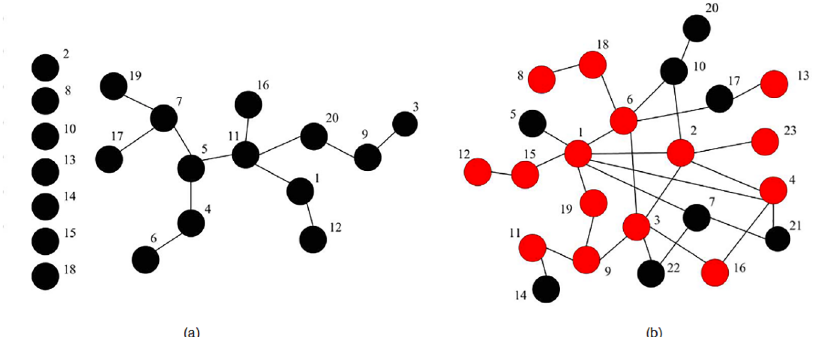
Fig 6. Interaction relations among high-connectivity players and their strategies in the stationary regime of evolutionary dynamics under (a) random interaction and (b) high-degree preference interaction. Defect temptation and upper-bound are set to b = 1.7 and W = 16, respectively.Cooperator is denotedwith black node and defector with red node.